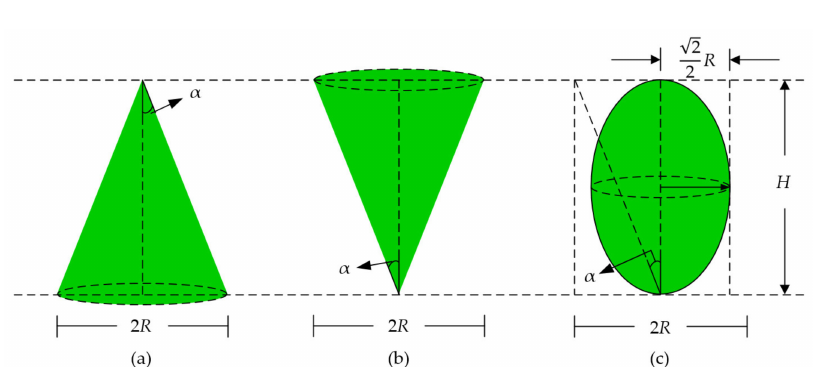
Figure 3. Geometric representations of the three specific crown shapes. The crown shapes, from left to right, are ( a ) cone, ( b ) inverted cone and ( c )